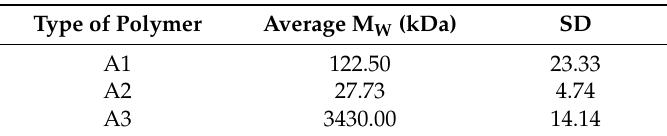
Table 2. Molecular weight (M w ) of synthesized polymers measured via static light scattering (SLS); SD—standard deviation.